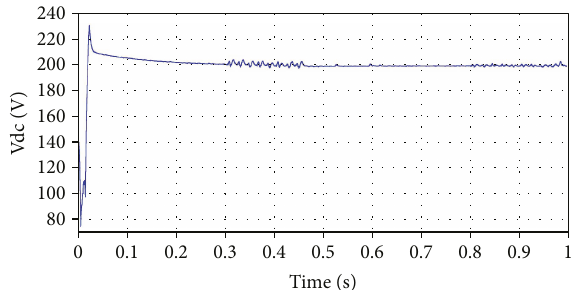
Figure 13: Capacitor voltage control in the STATCOM device with a